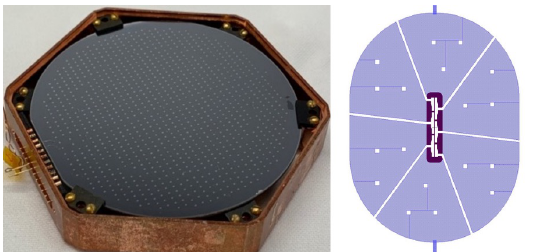
Figure 11: Left: A picture of the CPD installed in a copper housing. The instrumented side is shown facing up. Right: The design of the QETs used for the detector (blue: Al fins; purple: W TES). Figure and caption from Ref. [ 55 ] 4